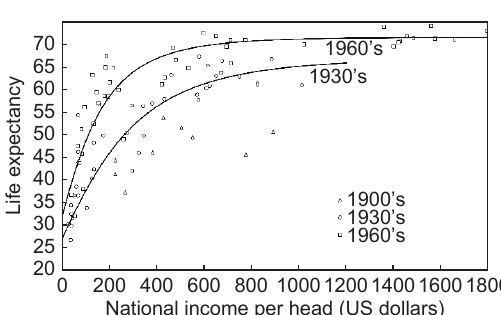
Fig. 1 Preston Curve (regenerated using the data in the original (1975) Preston paper), Scatter-diagram of relations between life expectancy at birth and national income per head for nations in the 1900’s, 1930’s, and 1960’s.